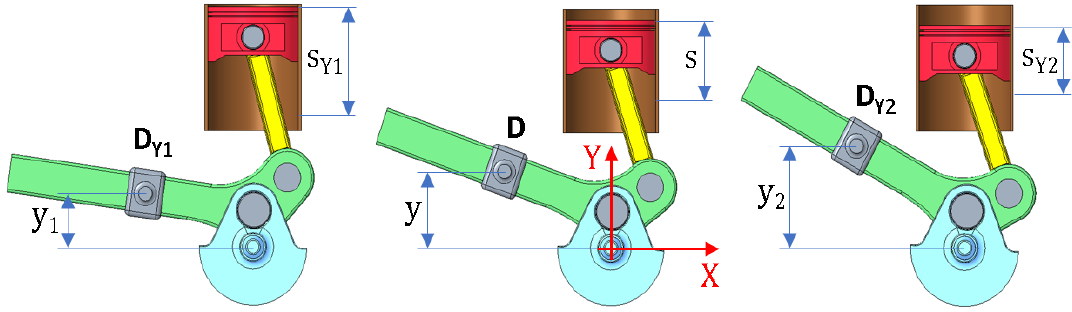
Figure 4. Piston stroke influence with modifying the pivot point on vertical direction.